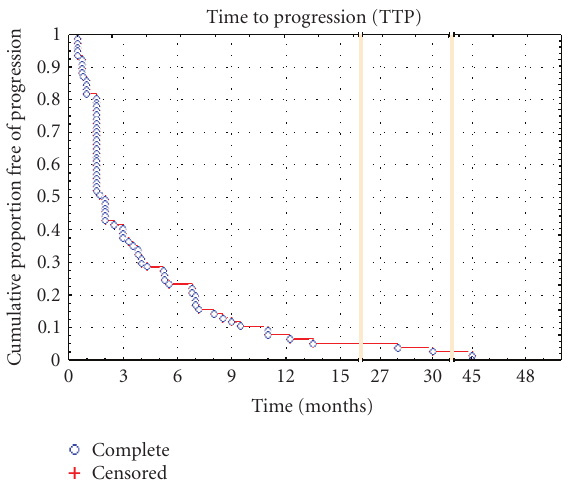
Figure 1: Kaplan-Meier curve of time to progression for the entire population.